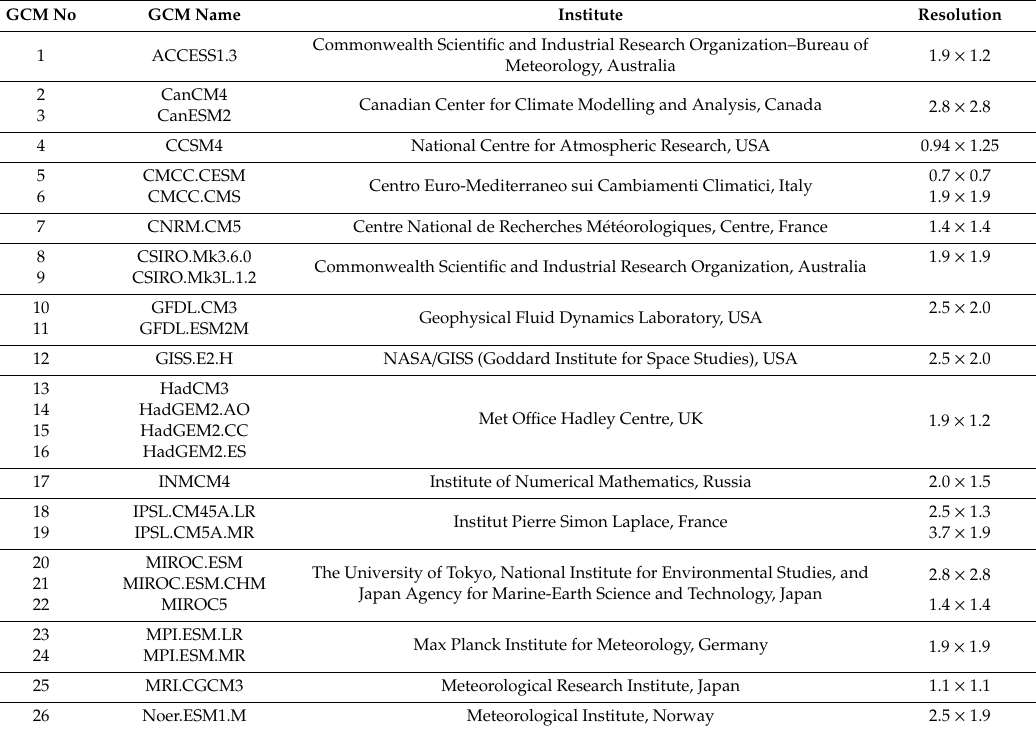
Table 1. General circulation models (GCMs) used in the study at 0.5 ◦